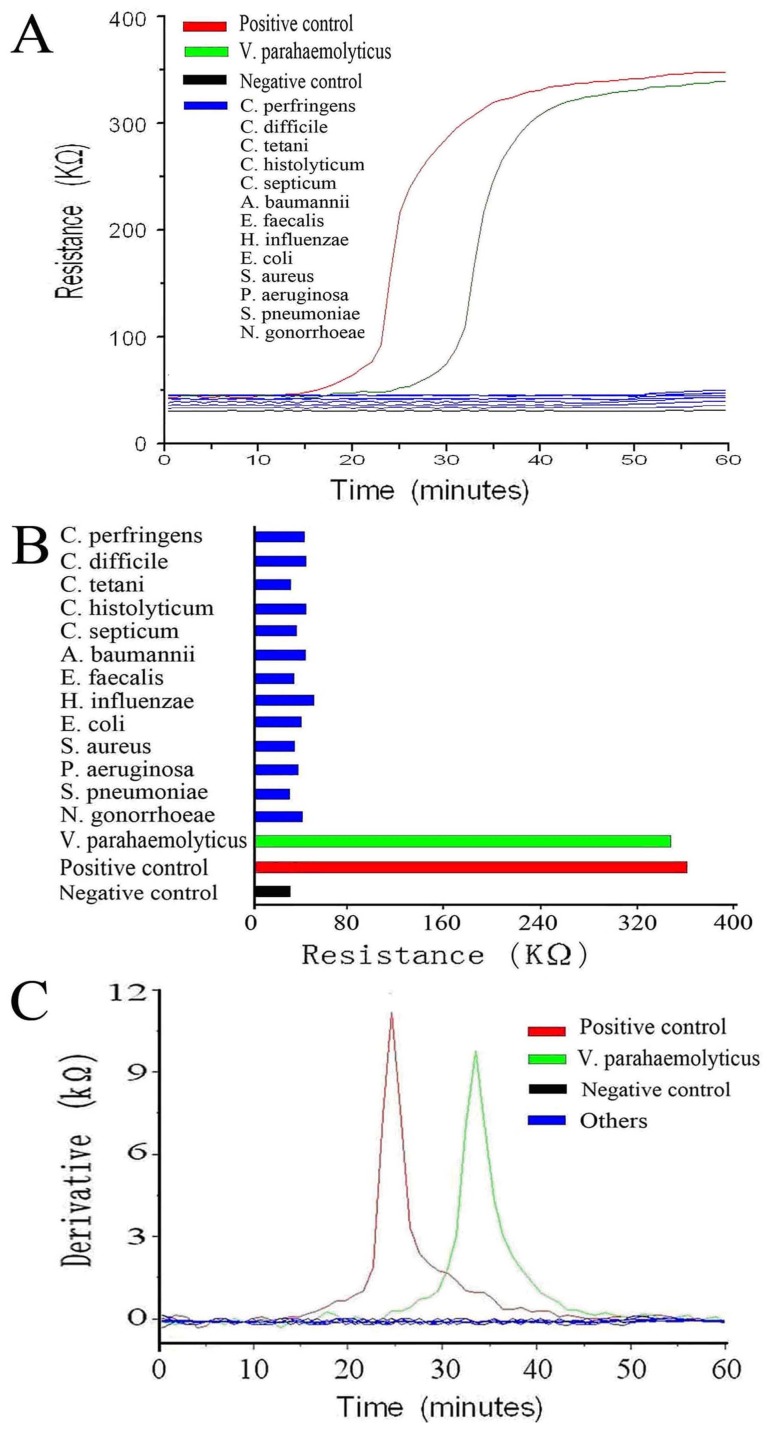
Specificity analysis of the real-time resistance measurement.A. The real-time resistance curve of V. parahaemolyticus and other interfering bacteria. B. End-point resistance of V. parahaemolyticus and other interfering bacteria after a 60-min LAMP assay. C. Derivative analysis of the real-time resistance measurement.